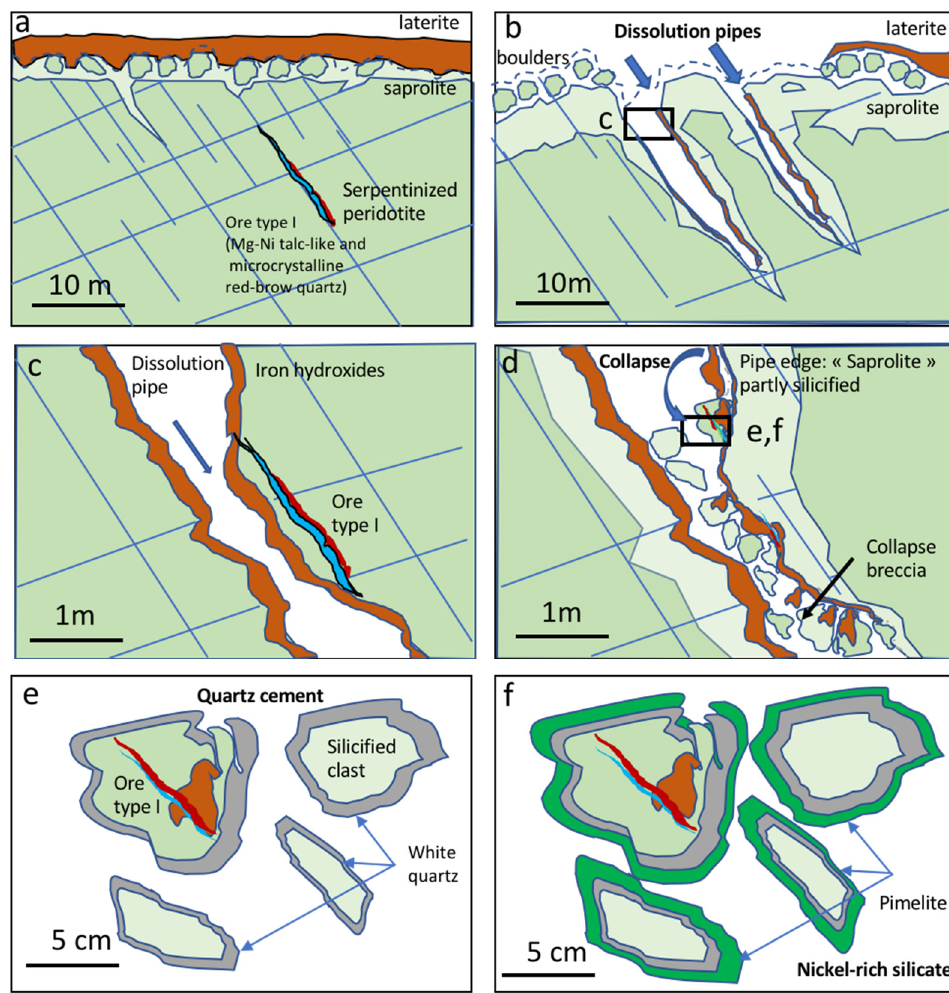
Figure 14. Main stages of silicified collapse breccia formation: ( a ) Formation of laterite and ore Type I as crack-seal fractures. ( b ) Development of dissolution pipes along previous fractures. ( c ) Detail of the dissolution pipes (inset c from b) with edges affected by saprolitisation and a layer of iron hydroxides. ( d ) Silicification and then the collapse of the dissolution pipes. The box refers to figures ( e , f ). ( e ) White quartz cement precipitation on clasts of silicified host rocks, and clasts of early ores. ( f ) Precipitation by evaporation of nickel-rich silicate (pimelite) on the white quartz rims. White quartz formed onto the block surface is posterior to the quartz crack-seals